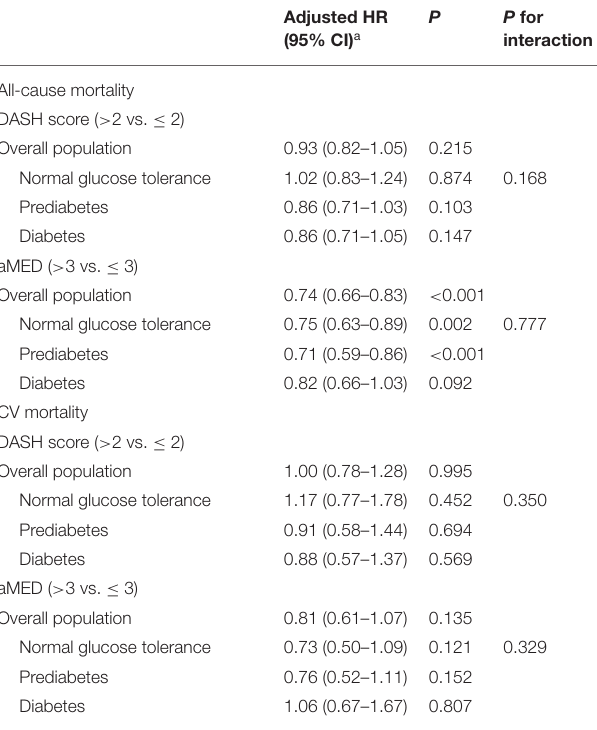
TABLE 4 | Joint effects of adherence to DASH and Mediterranean diet on all-cause